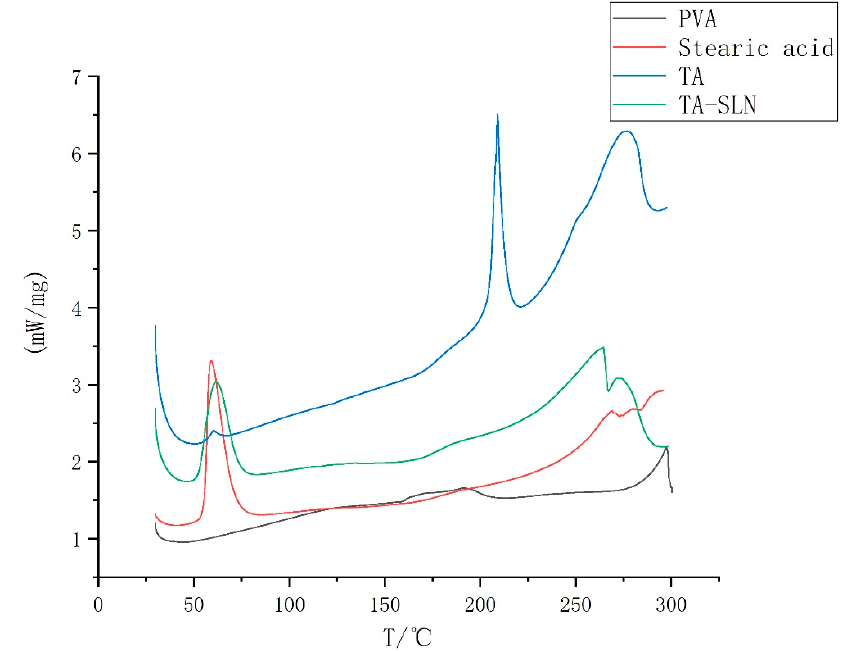
Figure 4. Differential scanning calorimetry (DSC) thermograms of PVA, stearic acid, TA and TA-SLN.